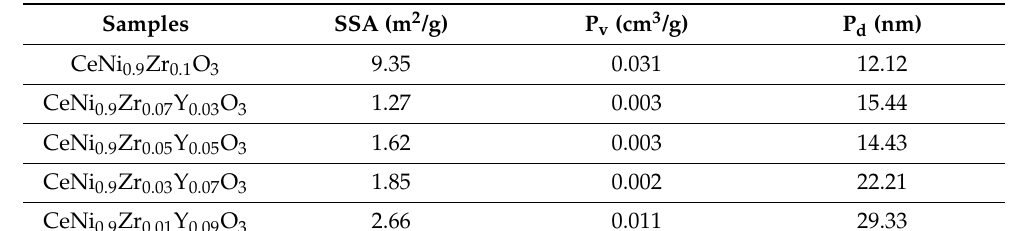
Figure 1. Nitrogen physisorption isotherms of perovskite catalyst CeNi 0.9 Zr 0 . 1 − x Y x O 3. (x = 0, 0.03, 0.05, 0.07, and 0.09). Table 1. Tabular presentation of Specific surface area (SSA), Pore volume (P v ), and Pore diameter (P d ) of the fresh catalyst samples.